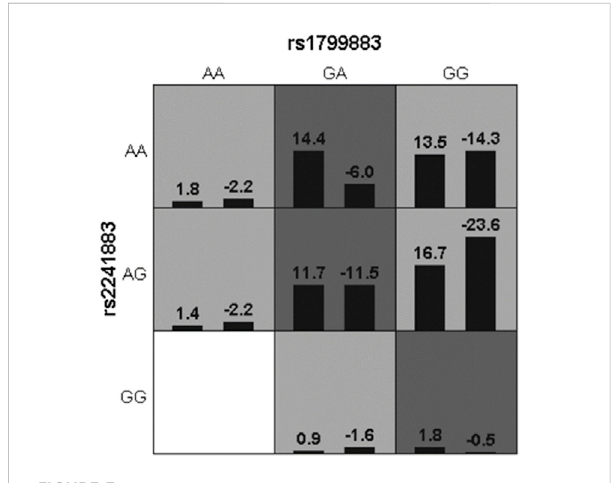
FIGURE 3 The optimal interaction model of rs1799883 and